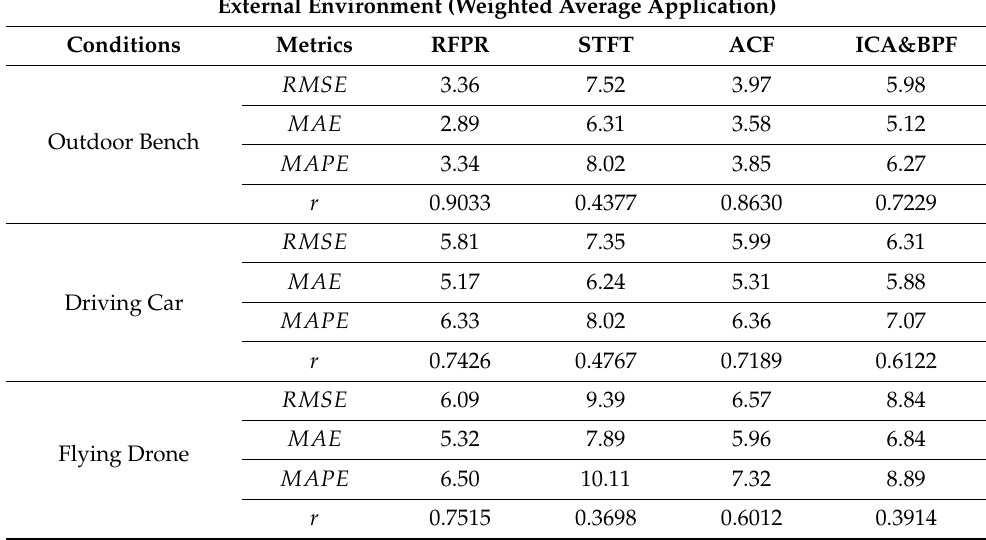
Table 3. Comparative results of the FPR on external